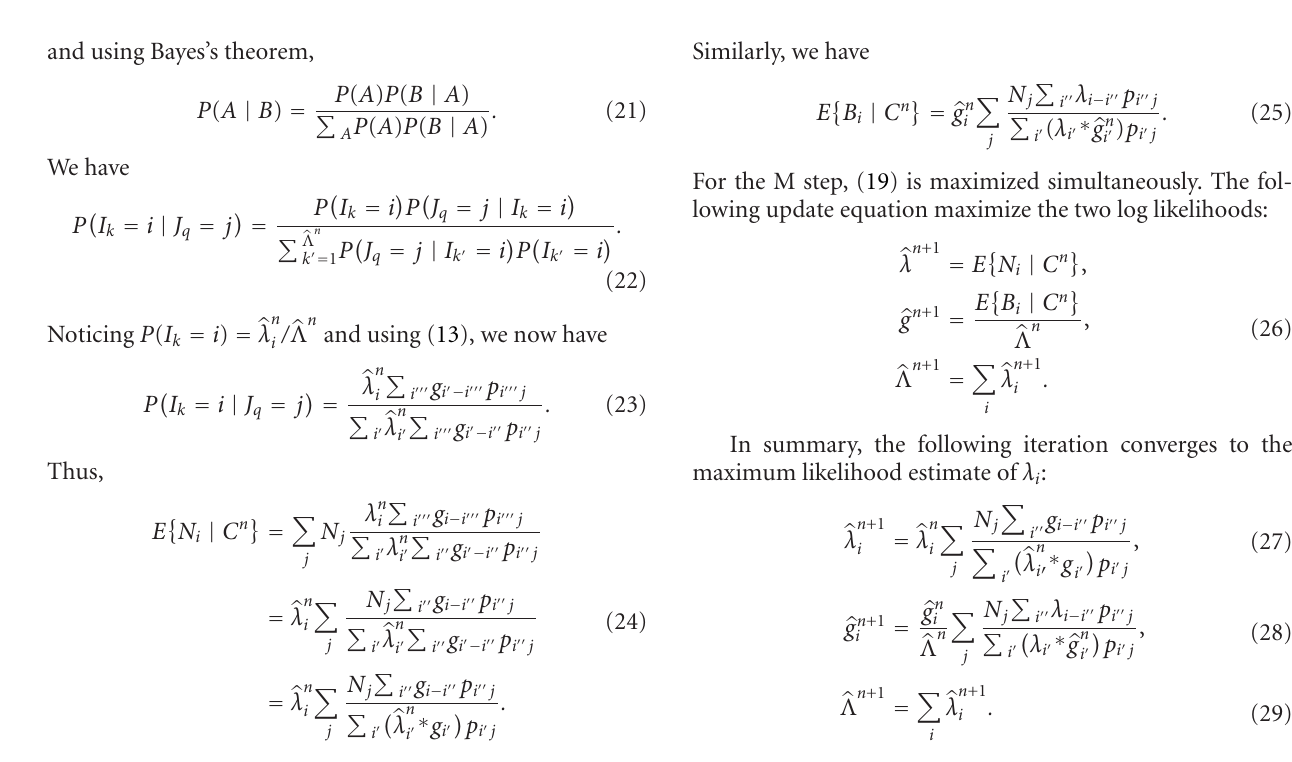
Figure 2: Reconstruction results for the ring of spheres phantom. (a) The ring of spheres phantom; (b) EM reconstruction of ideal projection data; (c) the same ring of spheres phantom with Poisson distribution with total counts of 10 6 ; (d) EM reconstruction with no PSF correction from blurry projection data of (a); (e) blind deblurring reconstruction; (f) reconstruction with known PSF correction; (g) EM reconstruction with no PSF correction from blurry projection data, with total photon count in projection data 10 6 ; (h) blind deblurring reconstruction; (i) reconstruction with known PSF